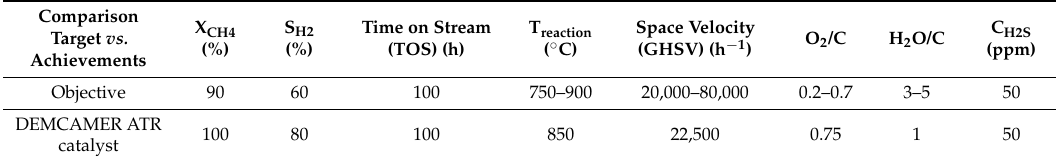
Table 2. Compliance of ATR catalyst developed in DEMCAMER with the requirements of activity, selectivity and durability [14,15].